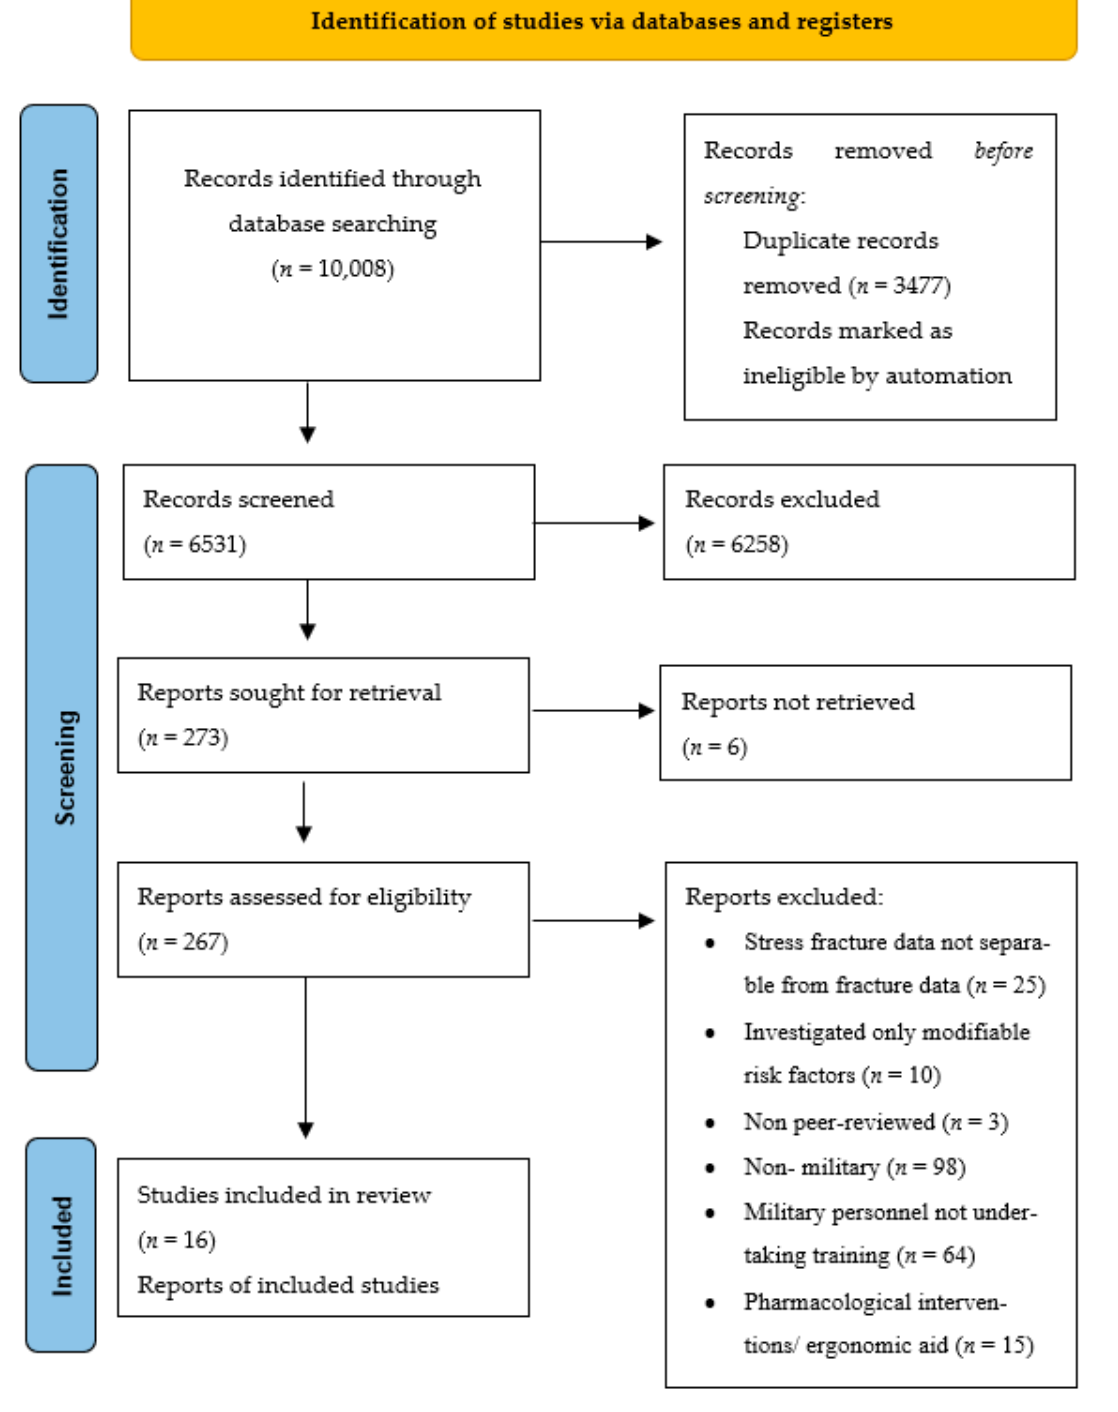
Figure 1. PRISMA 2020 flow diagram for new systematic reviews, which included searches of databases and registers only [34].